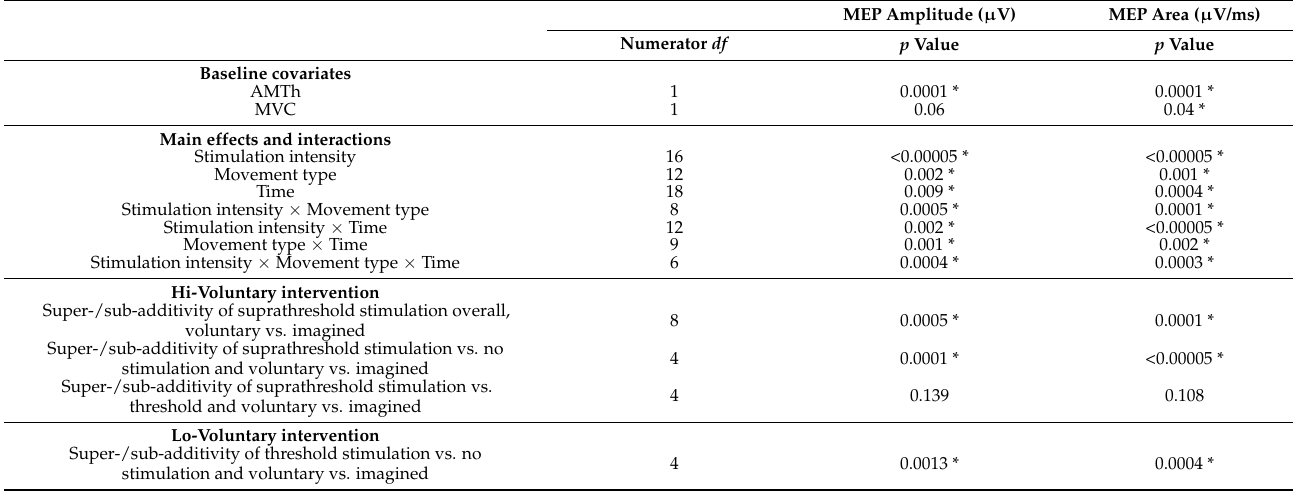
Table 2. Observed significance of baseline covariates and main and interaction effect estimates of absolute MEP amplitude and MEP